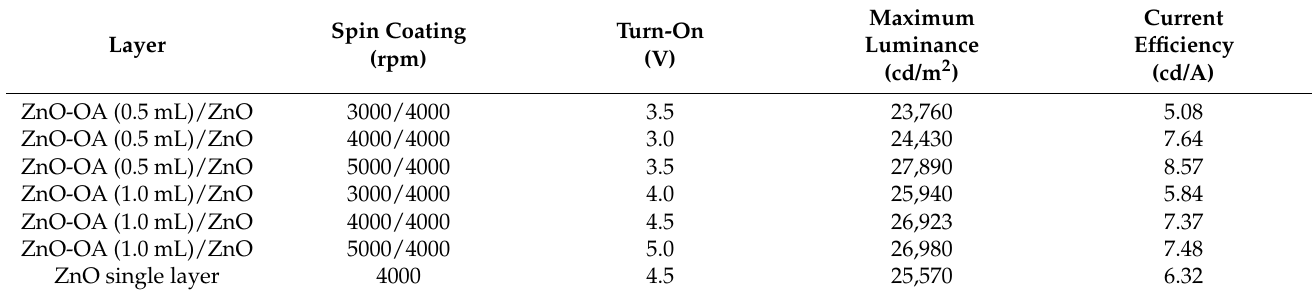
Table 1. QLEDs performance of a single ETL and double ETLs structure at various thicknesses.